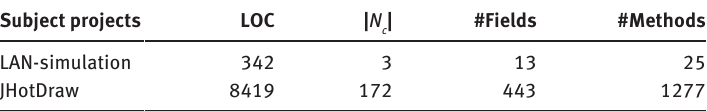
Table 1. Basic Data of the Subject